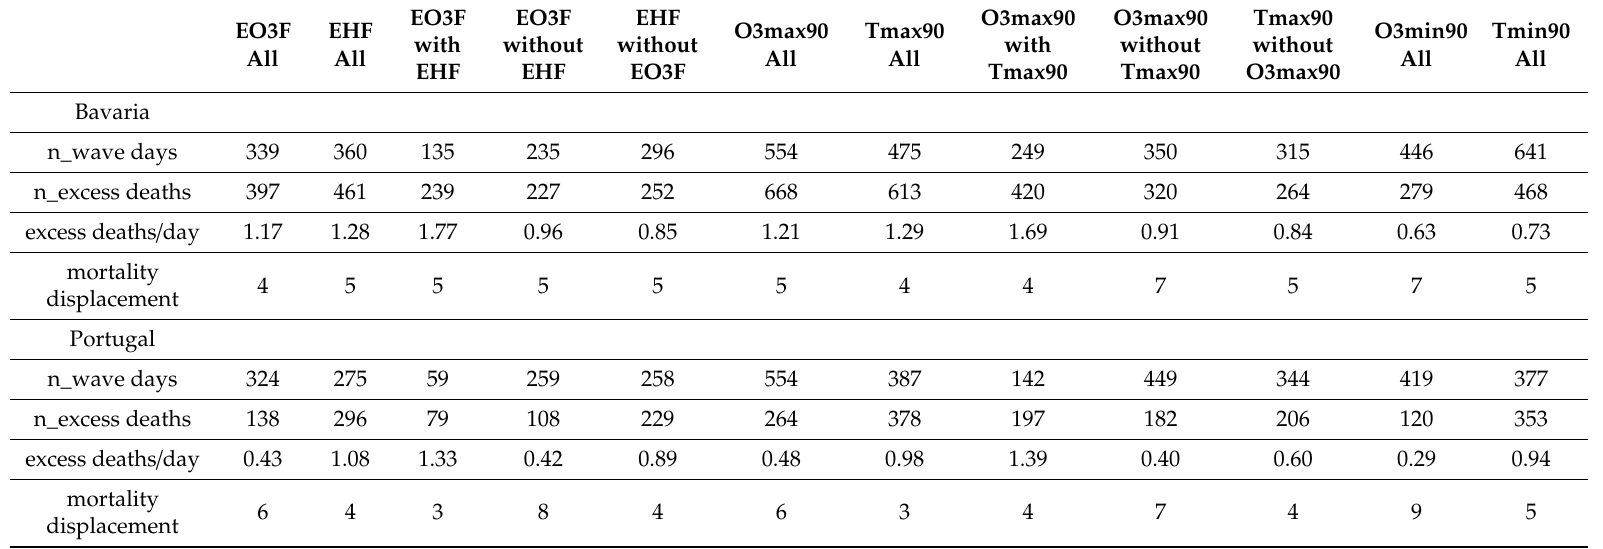
Table 1. Total number of wave days (n_wave days), number of excess deaths per 100,000 inhabitants (n_excess deaths), excess deaths per wave day (excess deaths / day) in the time period April–September 2003–2017, and mortality displacement in days for Bavaria and Portugal for each wave type. EO3F all (EHF all): All ozone (heat) waves according to the EO3F (EHF) definition, EO3F with EHF: Compound ozone-heat waves, EO3F (EHF) without EHF (EO3F): Single ozone (heat) waves without heat (ozone) wave conditions, O3max90 all (Tmax90 all): All ozone (heat) waves according to the O3max90 (Tmax90) definition, O3max90 with